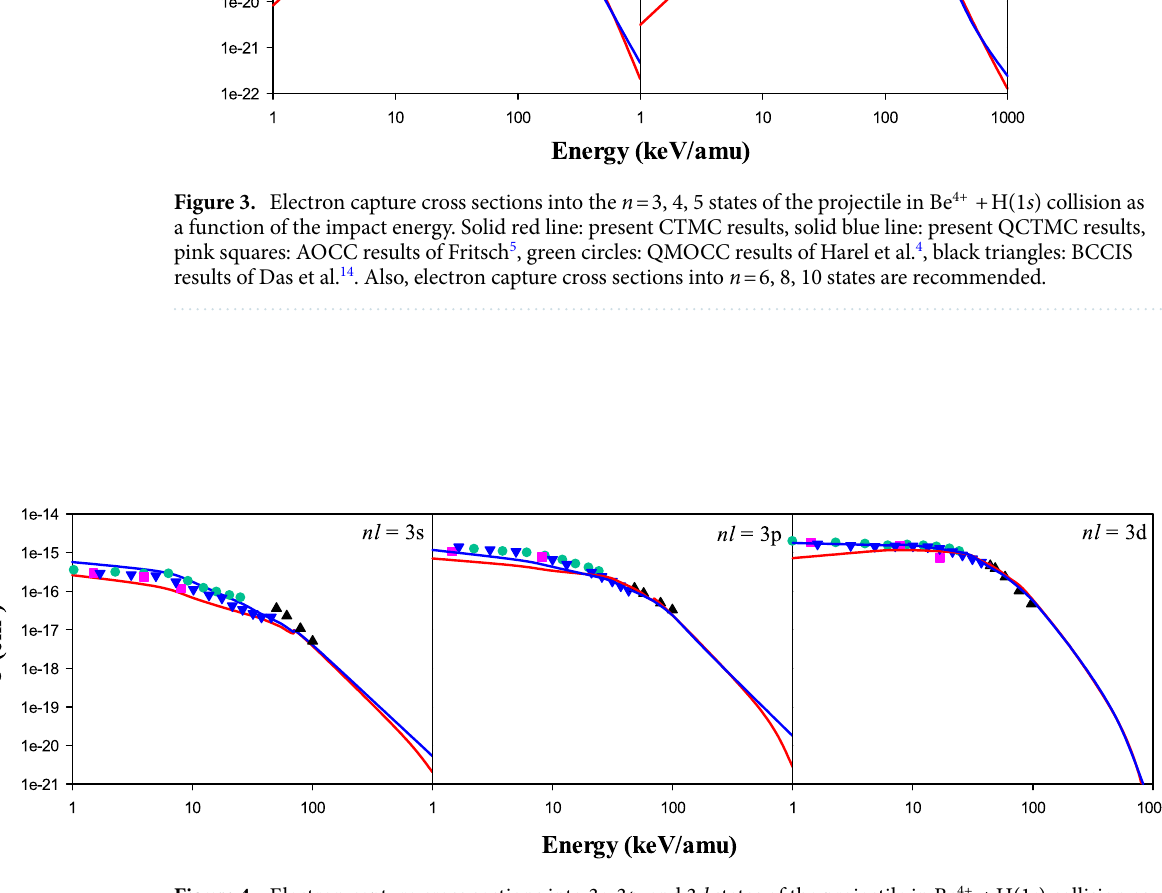
Figure 4. Electron capture cross sections into 3 s , 3 p , and 3 d states of the projectile in Be 4+ + H(1 s ) collision as a function of the impact energy. Solid red line: present CTMC results, solid blue line: present QCTMC results, pink squares: AOCC results of Fritsch 5 , green circles: QMOCC results of Harel et al. 4 , black triangles: BCCIS results of Das et al. 14 , blue inverse triangles: OEDM results of Errea et al. 13